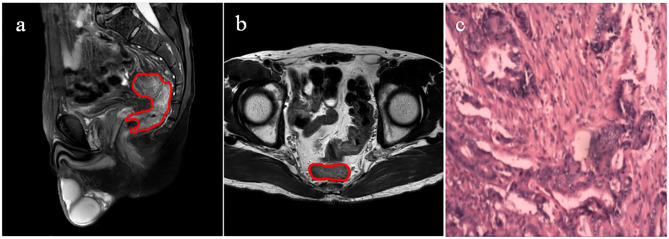
ROI segmentation in a randomly selected case based on sagittal fat-suppression and transverse T2WI. (a) Lesion ROI delineated on the sagittal fat-suppression T2WI. (b) Lesion ROI delineated on the routine transverse T2WI. (c) Pathological result.